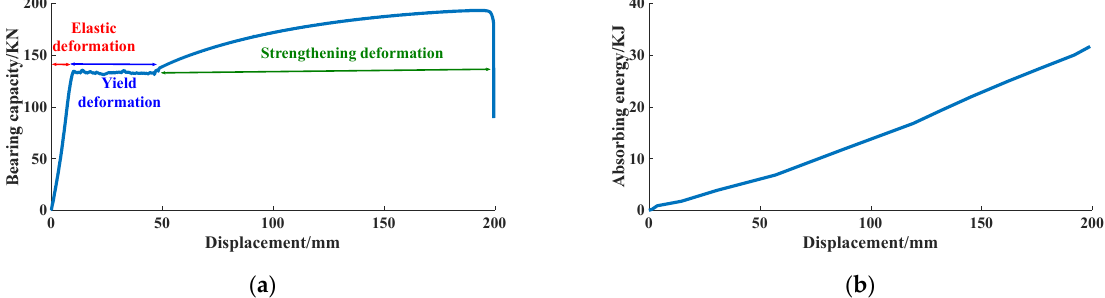
Figure 5. Mechanical property curves of conventional anchor rods ( a ) Bearing capacity-displace- ment curve; ( b ) Energy absorption characteristic curve.